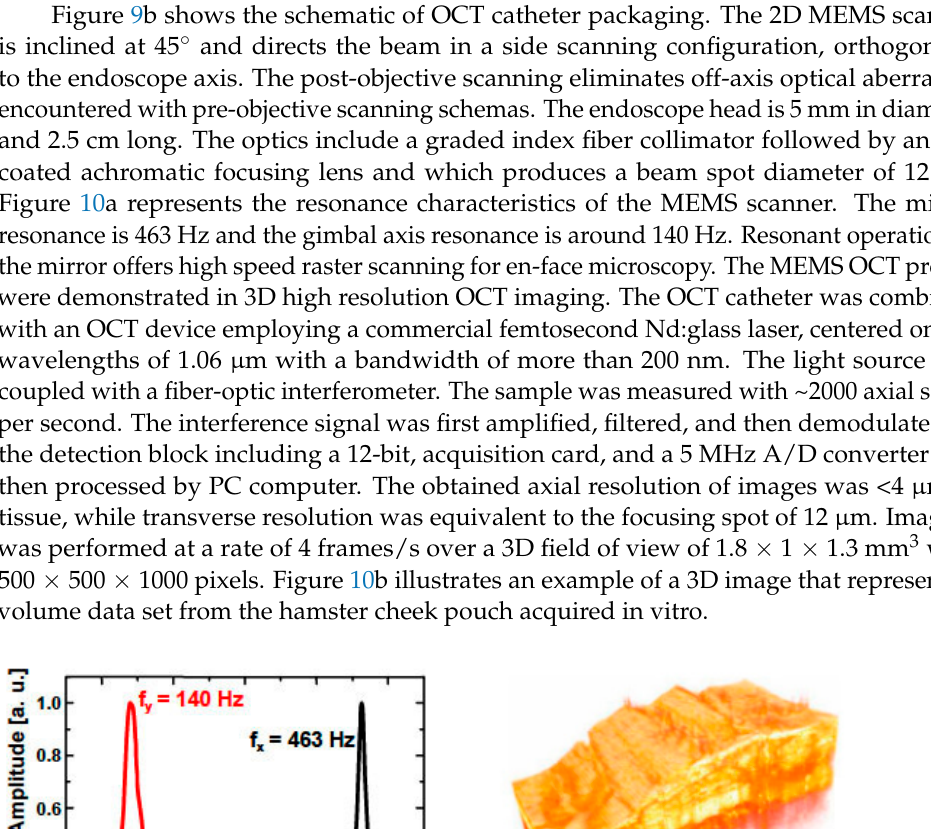
( b ) Figure 11. Cross-sectional view of the multichannel ”active” Mirau microinterferometer ( a ) with a focus on a 3D view of an electrostatic vertical microscanner with a 4 × 4 array of suspended reference micromirrors ( b ).